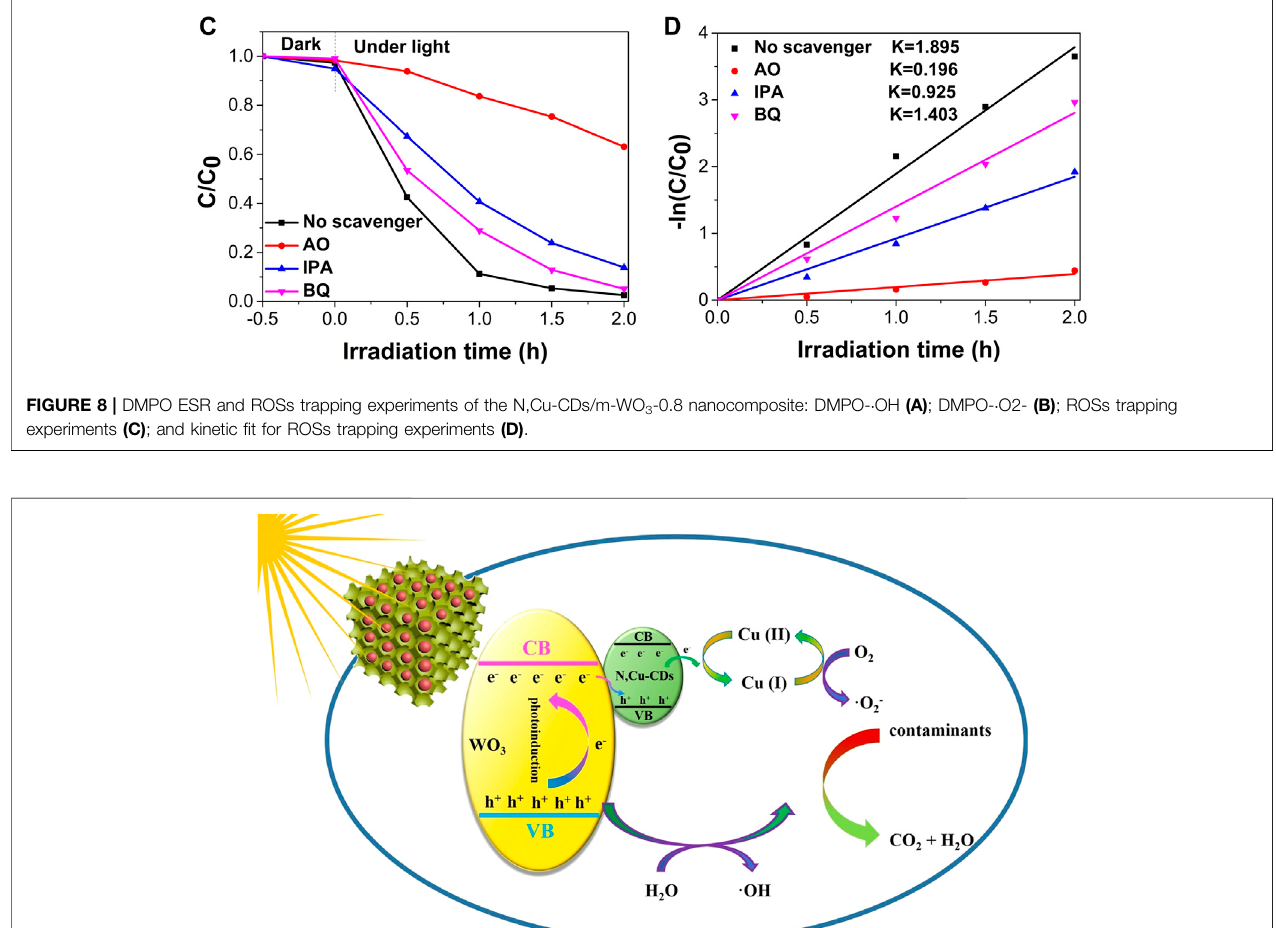
( Figure 7E ). The stability of the N,Cu-CDs/m-WO 3 -0.8 nanocomposite was studied via the cycling tests under visible- light irradiation for 2 h. Figure 7F shows that the nanocomposite maintained almost unchanged RhB photodegradation ef fi ciencies varying from 97.6 to 90.2% after a fi ve-cycle recycling, con fi rming the stable and reusable properties of the N,Cu-CDs/m-WO 3 -0.8 nanocomposite.